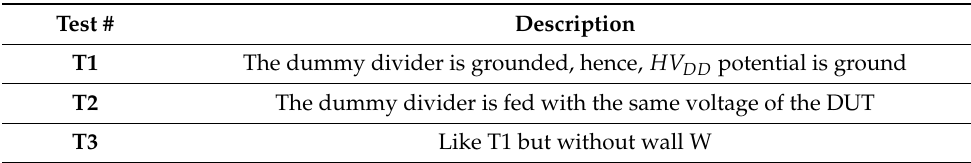
Table 2. Description of the test conditions considered in Section